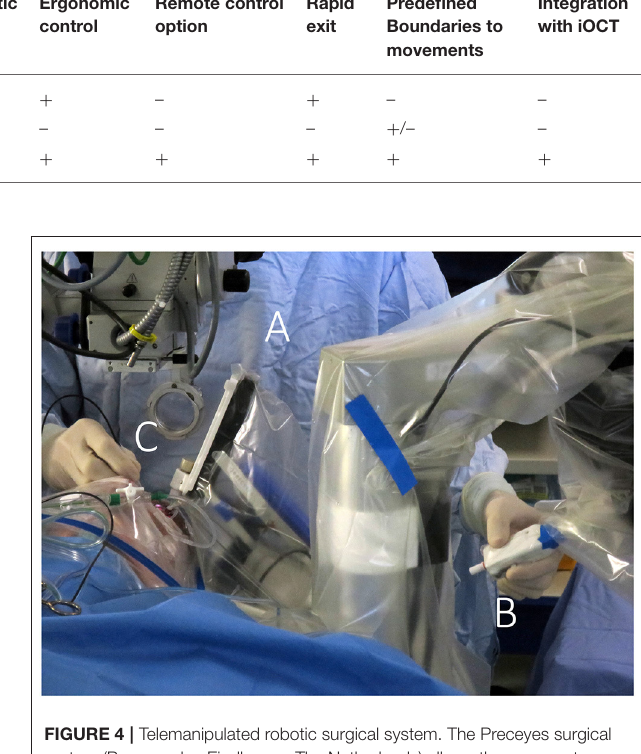
FIGURE 4 | Telemanipulated robotic surgical system. The Preceyes surgical system (Preceyes bv, Eindhoven, The Netherlands) allows the surgeon to control a robotic instrument manipulator (A) located on the side of the headrest via a motion controller (B) held in one hand of the surgeon, while endoillumination is provided by a light pipe (C) held in the other hand. A particular advantage is the non-obstructive design of the robot, allowing for hybrid manual/robotic surgery and natural integration with the regular work flow of ophthalmic surgery